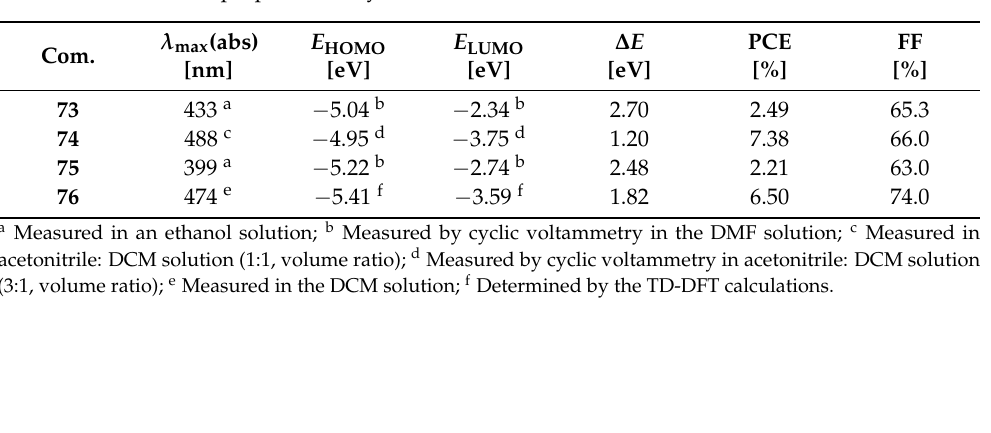
Table 6. Fundamental properties of dyes 73 – 76